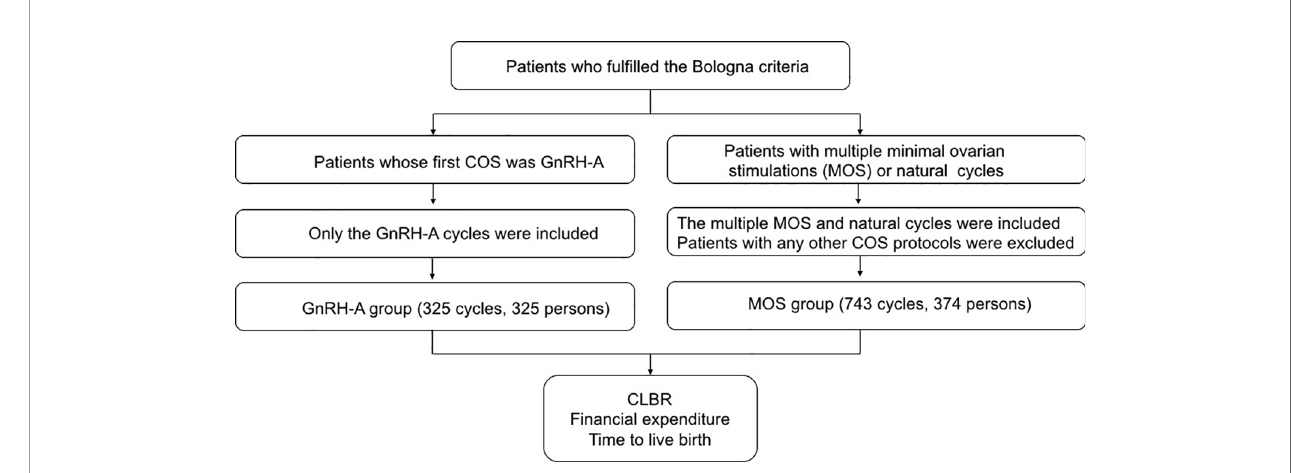
FIGURE 1 | Flow diagram of patient